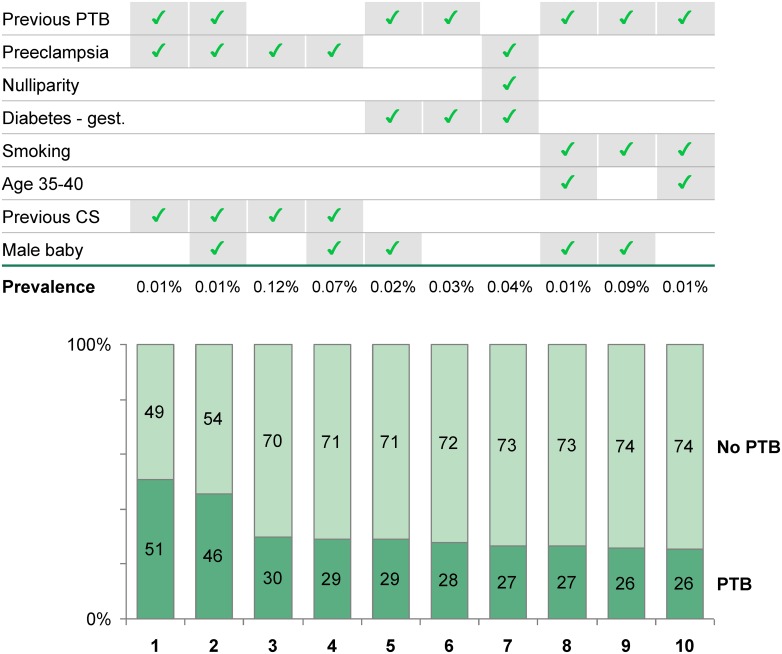
Top 10 subpopulations with highest probability of preterm birth.4 datasets (New Zealand, Czech Republic, Slovenia, Sweden) representing a total of ~3 million singleton pregnancies were combined. Subpopulations were defined by their unique combinations of risk factors (top) and ranked by probability of preterm birth (bottom). This analysis was restricted to risk factors common to all four datasets. Subpopulations with prevalence below 1 in 10,000 were excluded. Additional subpopulations are shown in Fig E of S1 Appendix. Abbreviations: PTB, preterm birth; gest, gestational; CS, cesarean section.